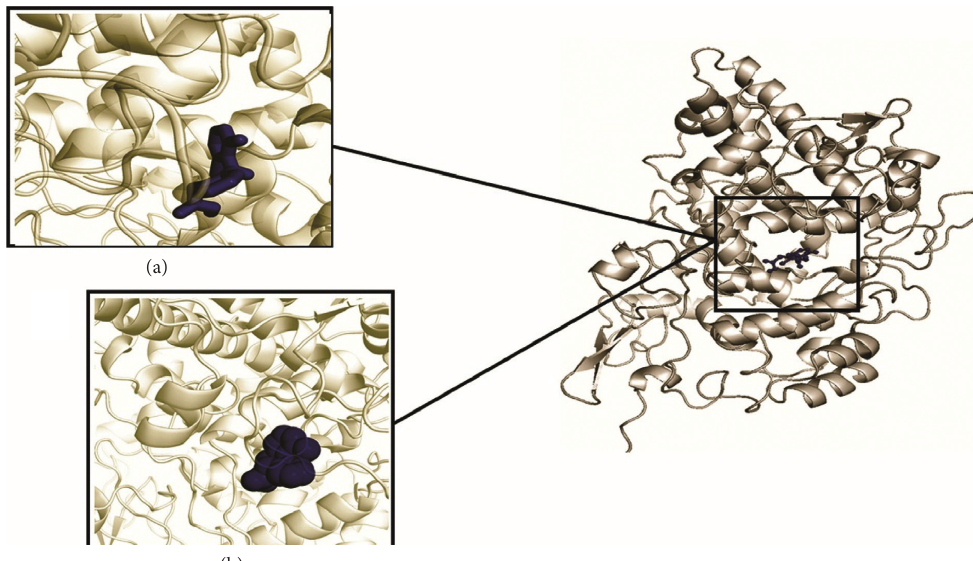
Figure 1: Binding of standard drug, diclofenac with COX-1 protein. (a) Representation of diclofenac binding with COX-1 in ball and stick form. (b) Representation of diclofenac binding with COX-1 in ball and space fill form.